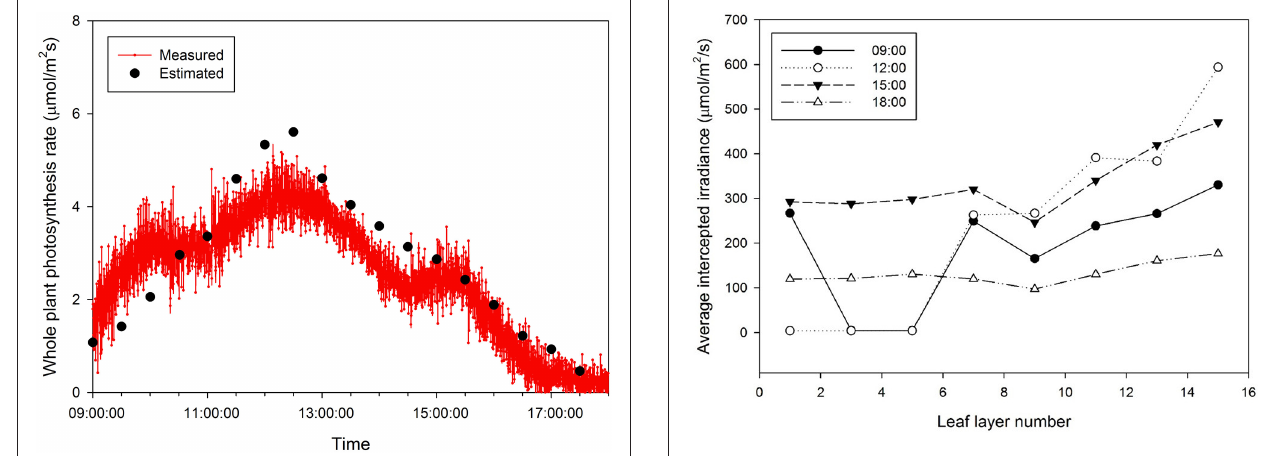
FIGURE 6 | A comparison of measured and estimated photosynthesis rates of the entire plant on 15 October 2014.